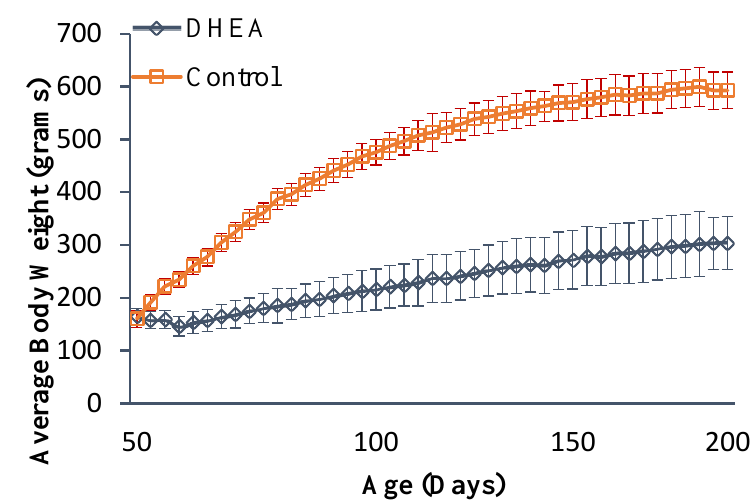
Figure 1. Mean ± SD body weight of obese rats with and without DHEA treatment. (Modified from Oncol Rep . 2010 , 24 , 357–362) [19].